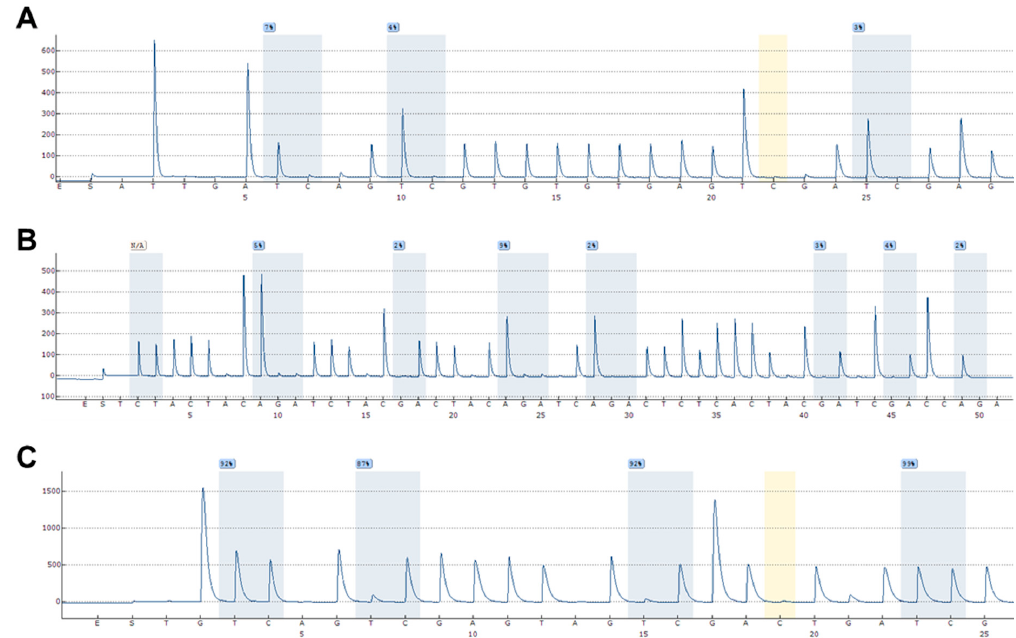
Figure 3. Representative DNA methylation data acquired using pyrosequencing. ( A ) ELMO1 ; ( B ) ELMO2 ; ( C ) ELMO3 .